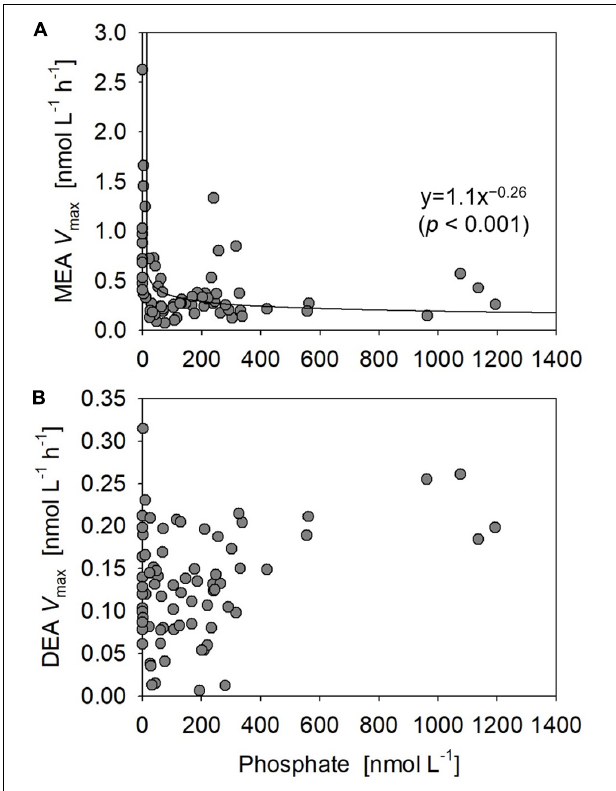
FIGURE 9 | Relationships between phosphate concentrations vs. (A) monoesterase and (B) diesterase activities (MEA and DEA V max ) obtained at all